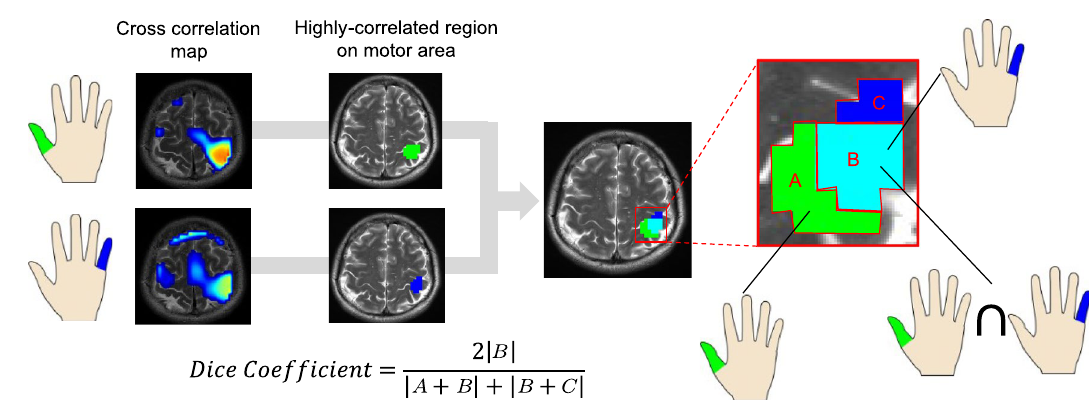
Figure 3. Definition of the Dice coefficient used in this study to assess how clearly the activated regions corresponding to the thumb and the little finger tasks were separated. The Dice coefficient was calculated for the extracted activation-related regions of the thumb (green) and little finger (blue) for each subject. The light-blue area corresponds to the overlap between the activation-related regions for the thumb and little